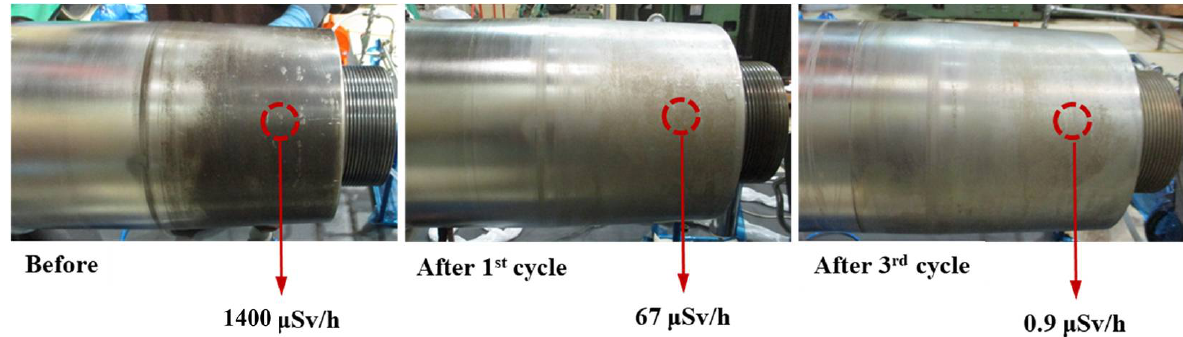
Figure 10. Photos of the RCP shaft head after each cycle.